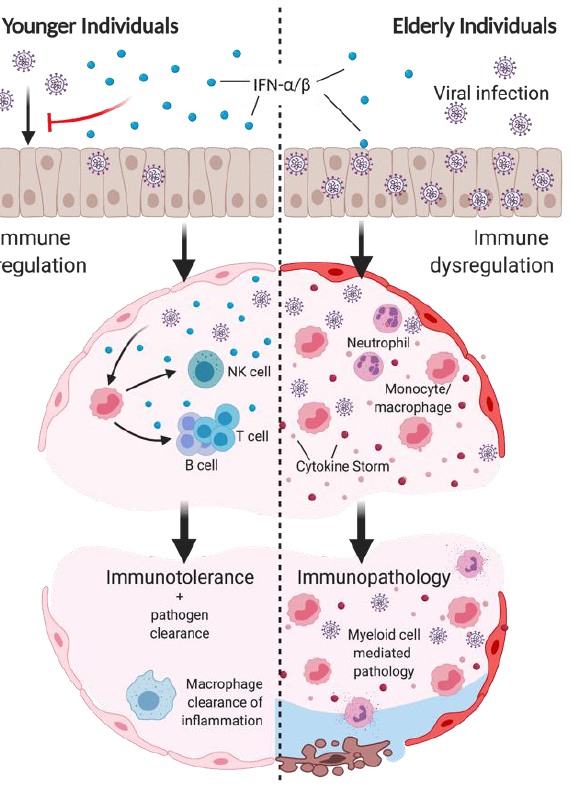
Figure 2. Impaired type I IFN induction in aging impairs viral clearance and promotes immunopathology following infection. Top: reduced IFN- α / β production in elderly individuals in the upper respiratory tract impair control of early viral replication. Middle left: type I IFN production of epithelial cells and myeloid cells regulates immune response to infection to promote viral clearance. Type I IFN responses induce inflammatory monocyte/macrophage (IMM) recruitment and activation, subsequently inducing NK cell recruitment and activation. IMM production of IL-12/15/18 promotes DC maturation to induce T and B cell functions. Bottom left: immune-mediated viral clearance, as well as macrophage-mediated resolution of inflammation promotes immune tolerance to infection. Middle right: Suppressed type I IFN induction in elderly individuals impairs the control of excessive IMM and neutrophil infiltration, and cytokine storm. Bottom right: IMM and neutrophils mediate significant damage to the airways and cause disease pathology to infection. Created with BioRender.com.